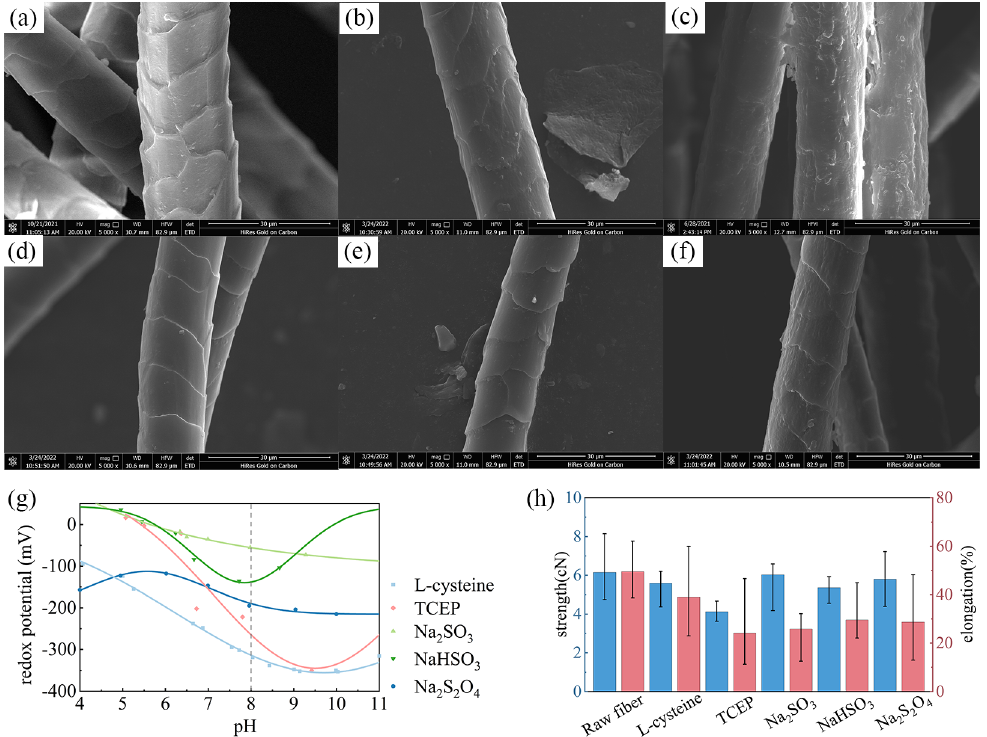
Figure 2. SEM images of wool fibers treated with different reductants: ( a ) raw fibers; ( b ) L-cysteine; ( c ) TCEP; ( d ) Na 2 SO 3 ; ( e ) NaHSO 3 ; ( f ) Na 2 S 2 O 4 . ( g ) The redox potential of different reductant solutions; ( h ) the breaking strength and elongation of fiber samples. Redox potential is used to reflect the redox properties of substances in an aqueous solution, where a negative potential indicates that the solution has certain reducibility.